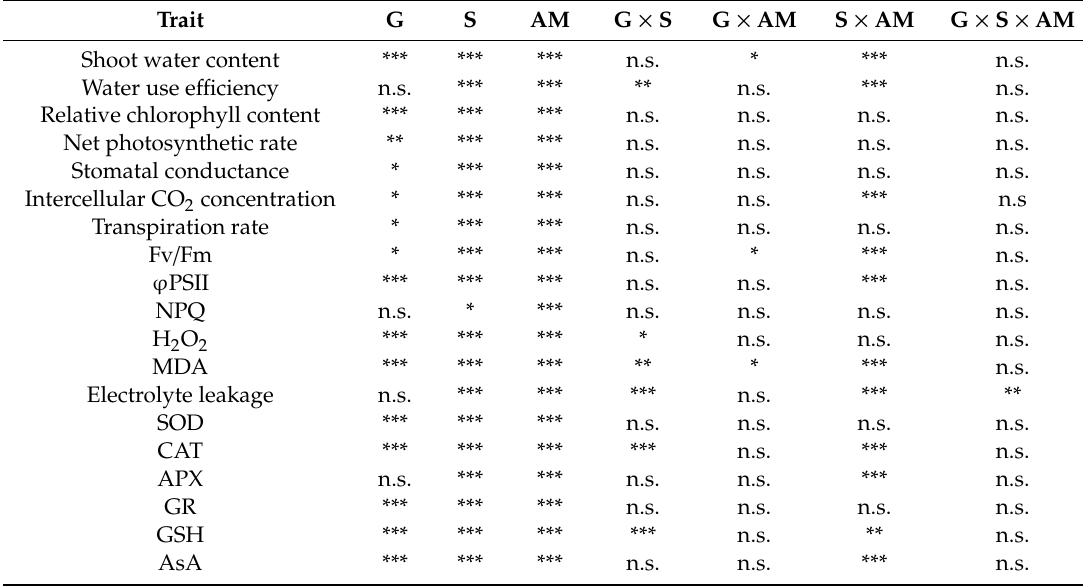
Table 1. Significance of three-way ANOVA for 19 physiological and biochemical traits in two maize genotypes (JD52 and FSY1) inoculated with Funneliformis mosseae (arbuscular mycorrhizal) (AM) or without inoculation (non-mycorrhizal) (NM) in 0 and 100 mM NaCl treatments assessed at 59 days after sowing